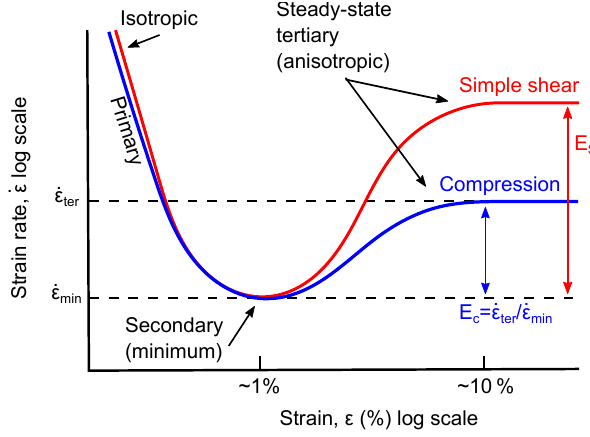
Figure 1. Schematic illustrating strain rate characteristics of poly- crystalline ice undergoing deformation driven by single stresses as measured in laboratory experiments. The part of the curve corre- sponding to tertiary (steady-state) anisotropic creep is relevant to the deformation of ice masses in typical ice sheets and glaciers. The red (blue) curve illustrates the result of simple shear-alone (compression-alone) stress configurations. The ratio of the shear en- hancement factor E S to the compression enhancement factor E C is approximately 8 / 3 (Treverrow et al., 2012), and the enhancement due to compression-alone is approximately three times that of the secondary (minimum) creep